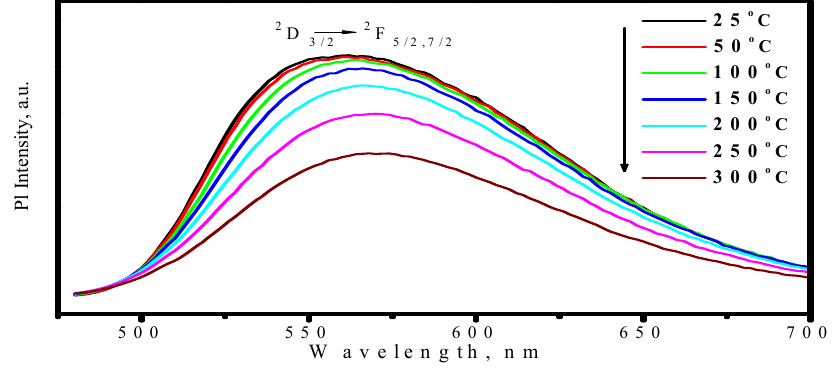
Figure 5. Emission spectra of YAG:Ce 3+ upon Ce 3+ emission at 560 nm measured at different